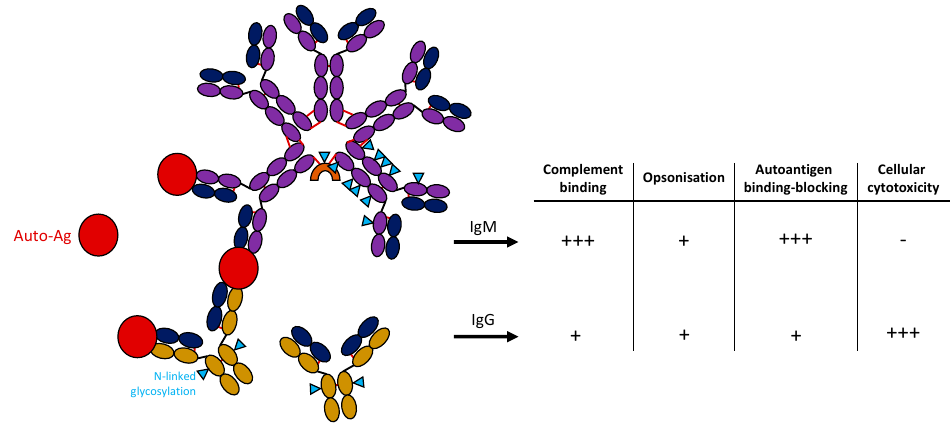
Figure 1. Structure of IgM and IgG antibodies and potential function in autoimmunity. IgM antibody is shown in a pentameric form containing a J-chain (orange) binding autoantigen (red). IgG monomers are shown below. N-linked glycosylation sites of antibodies are marked with a blue triangle. Table on the right shows critical features of antibodies comparing IgM and IgG antibodies.